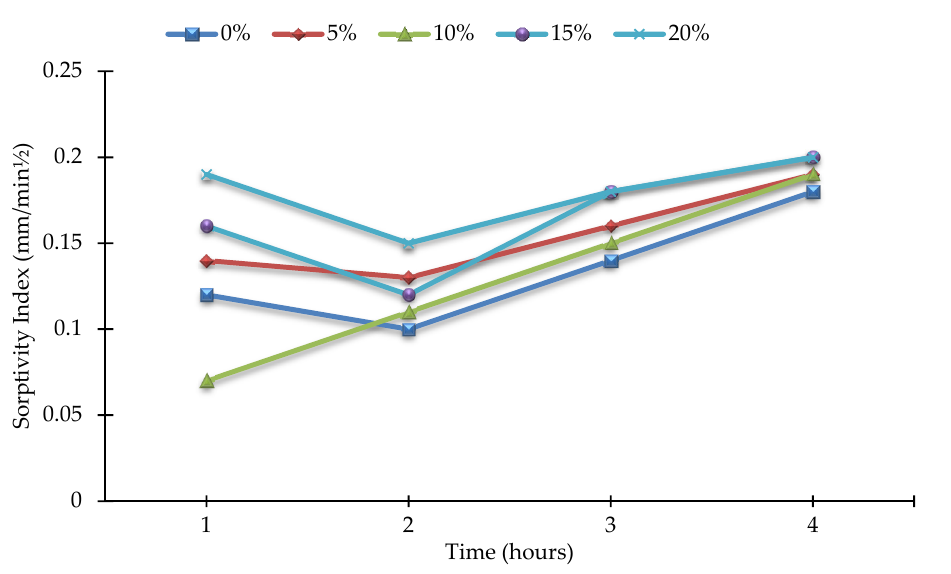
Figure 14. Rate of change of sorptivity index for all mixes.